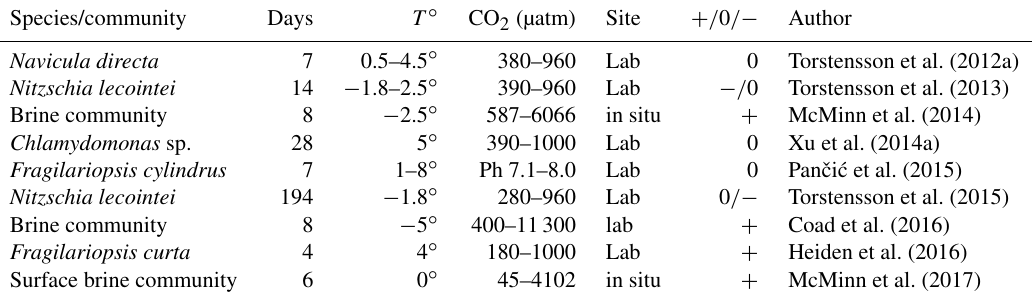
Table 1. Ocean acidification experiments on sea ice microorganisms. The column “ + / 0 / − ” indicates whether the organisms in the study responded positively “ + ”, no change “0” or negatively “ − ” to the change in CO 2 concentration. Species/community Days T ◦ CO 2 (µatm) Site + / 0 / − Author Navicula directa 7 0.5–4.5 ◦ 380–960 Lab Nitzschia lecointei 14 Brine community Chlamydomonas sp. Fragilariopsis cylindrus Nitzschia lecointei Brine